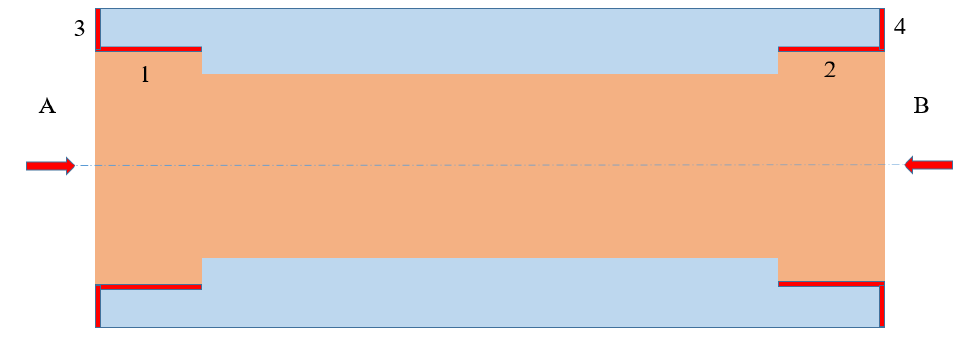
Figure 4. Marking diagram of shape and position tolerance of motorized spindle.